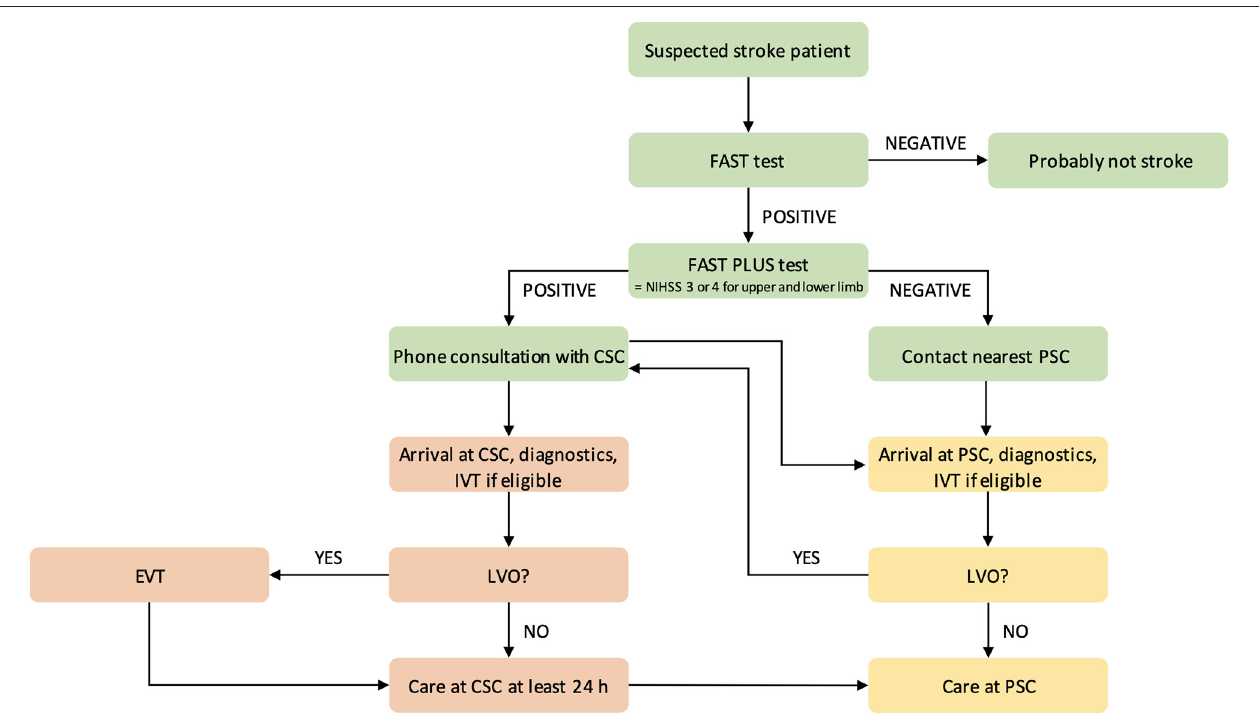
FIGURE 2 | Flowchart of prehospital triage in the Moravian–Silesian region, Czech Republic, after the triage change. CSC indicates comprehensive stroke center; PSC, primary stroke center; IVT, intravenous thrombolysis; EVT, endovascular treatment; and LVO, large vessel occlusion.